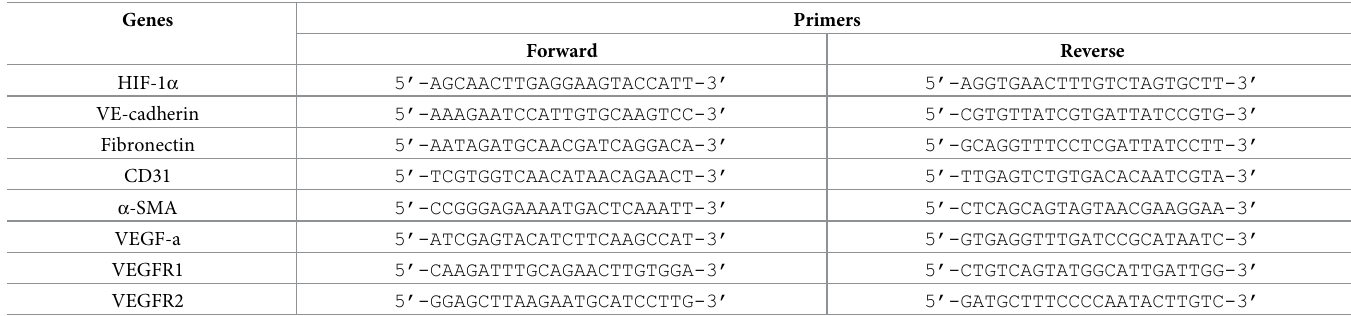
Table 1. The primers for PCR analyses.